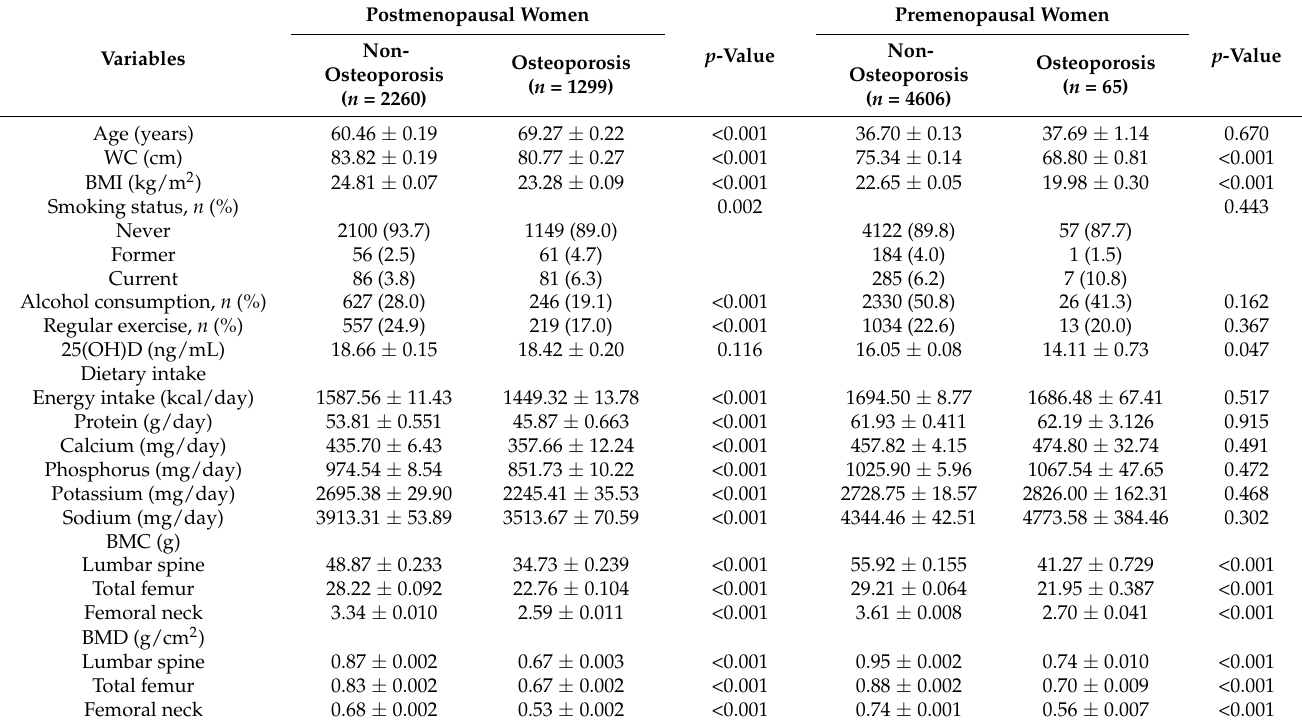
Values are expressed as the mean ± standard error of the mean for continuous variables or as the number (percentage) for categorical variables. WC, waist circumference; BMI, body mass index; BMC, bone mineral content; BMD, bone mineral